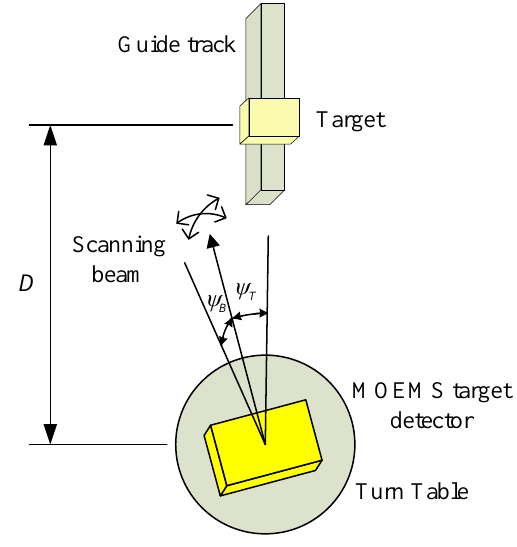
Figure 14. Experimental system for MOEMS target detector.